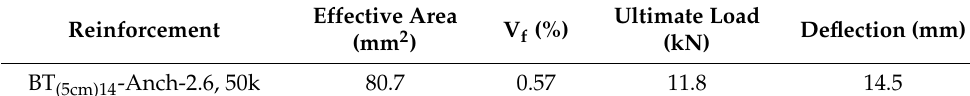
Table 4. Results of bi-axial TRC beams.